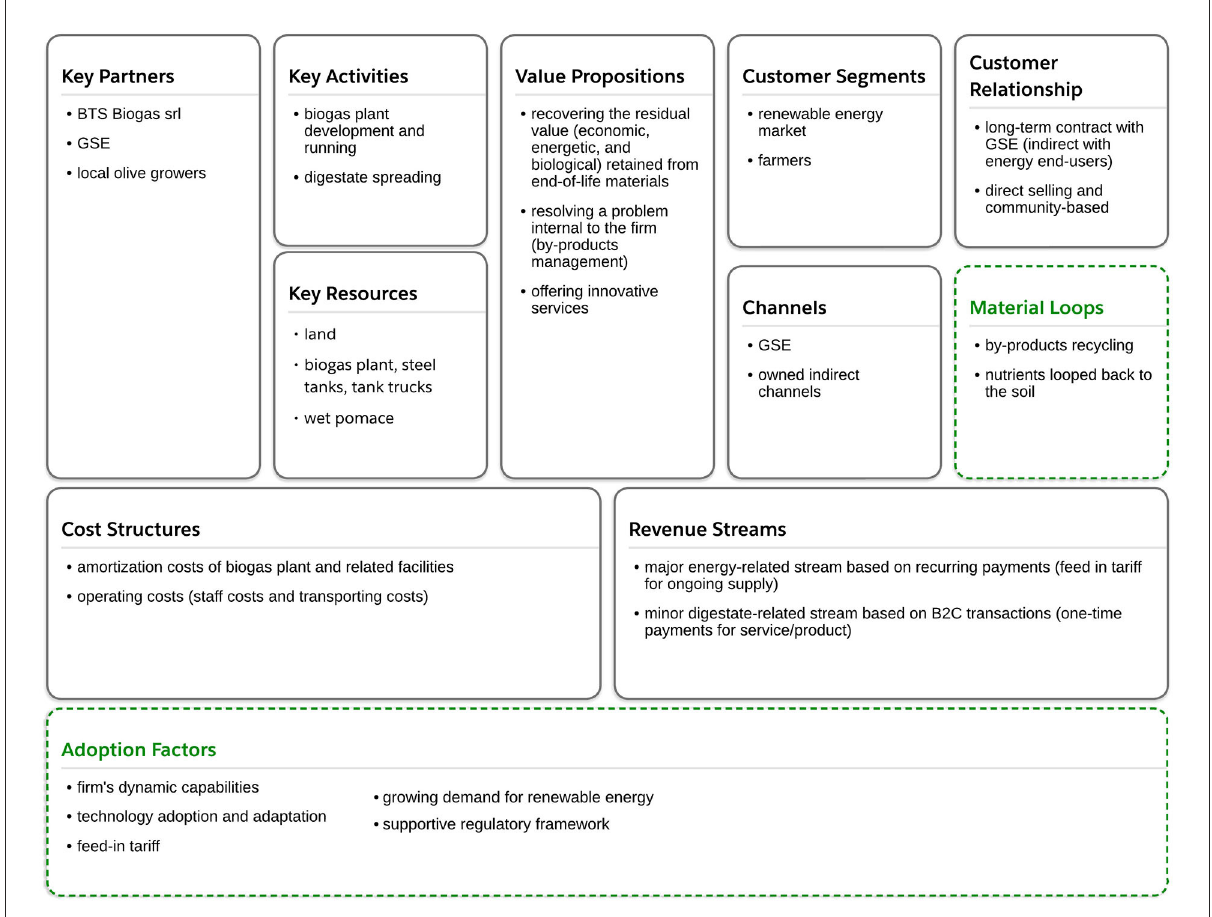
FIGURE3 The case study’s CBMC, whose additional components are marked in